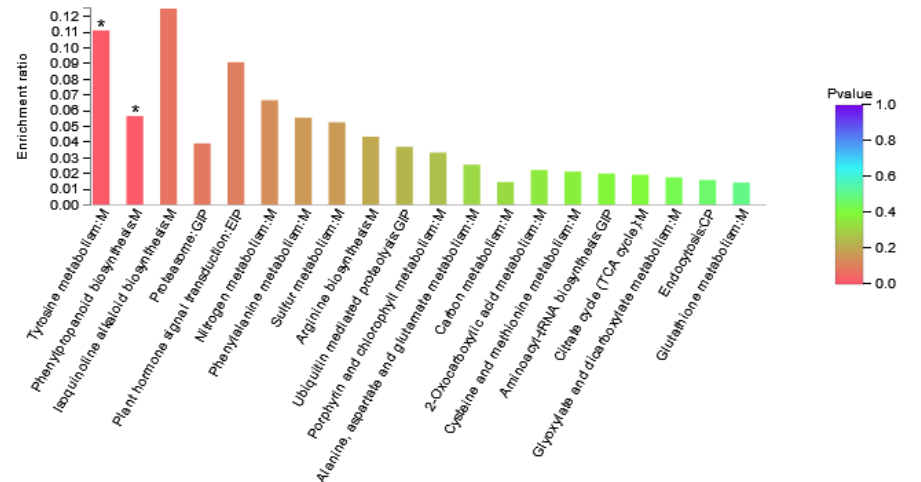
Figure 5. Enriched KEGG pathways of Area I. The abscissa represents the pathway name. The ordinate represents the enrichment rate, which refers to the ratio of the number of proteins enriched in this pathway to the number of proteins annotated into the pathway. The higher the ratio, the greater the degree of enrichment. Column color gradient indicates the significance of enrichment, where p < 0.05 is marked with *.